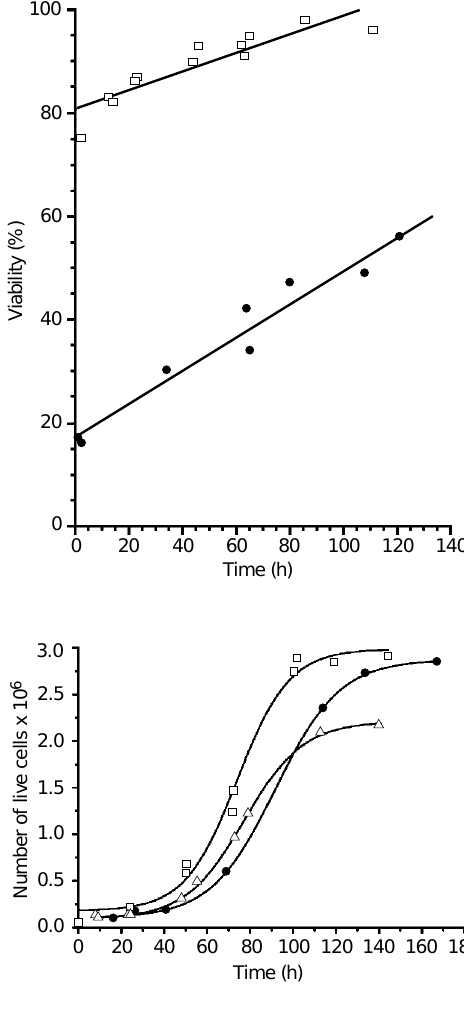
2. Viability as a function of time for A31 (squares) and B61 cells (circles) after treat- ment with the anionic porphyrin (TPPS 4 ) and light irradiation.